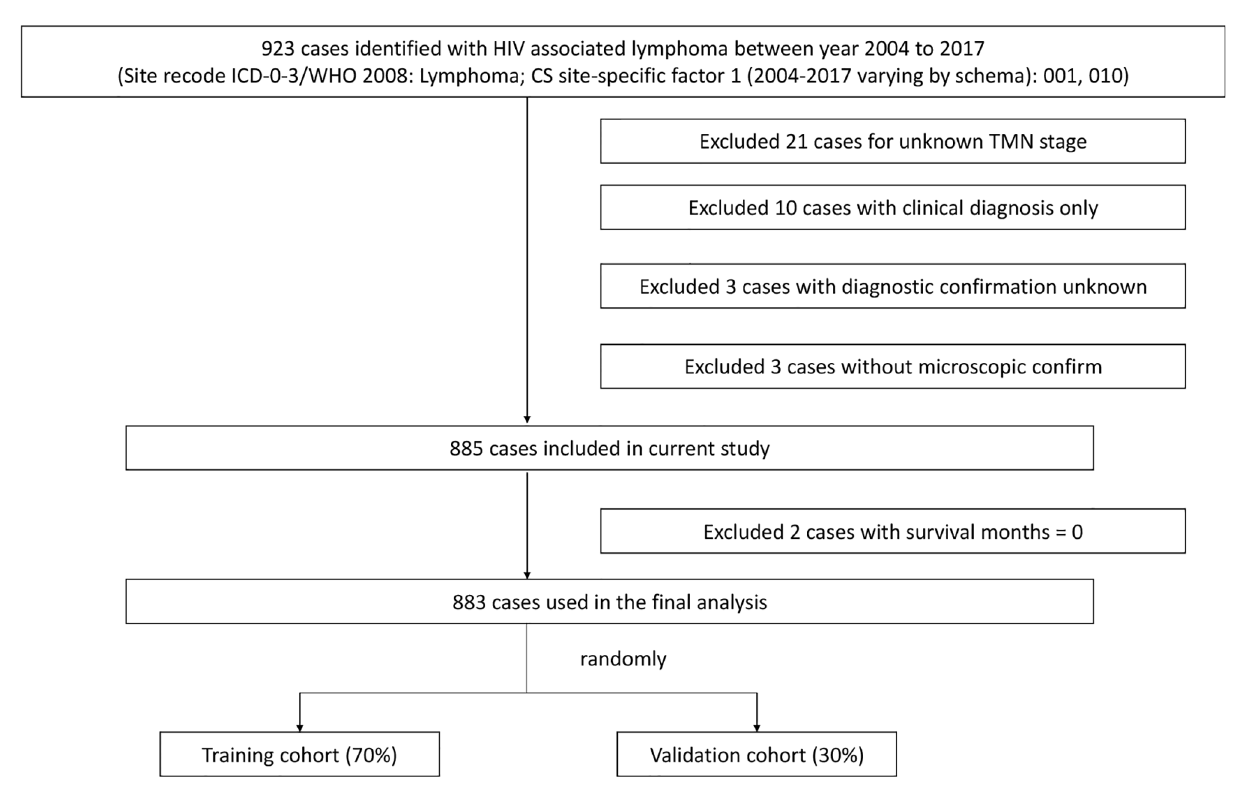
FIGURE 1 | Flowchart of the selection process of patients in the SEER database. SEER, Surveillance, Epidemiology, and End